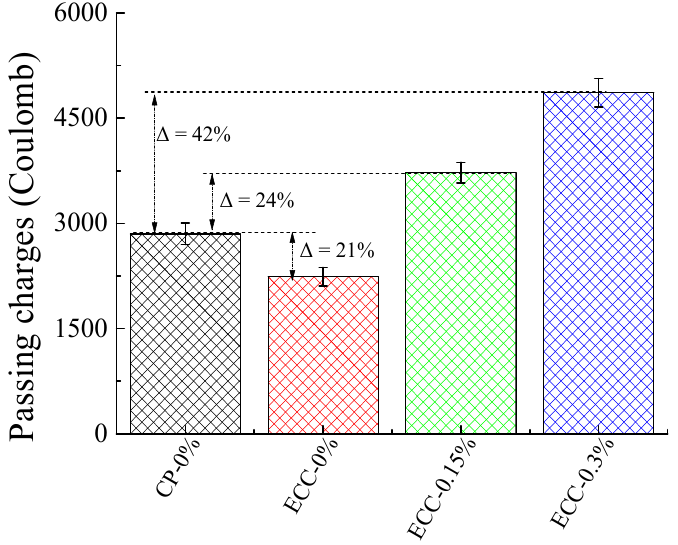
Figure 5. Total charges passed through CP and ECC grouts at 28-days curing. ECC specimens were significantly lower than CP specimens for the total passed charges. Table 3. Chloride permeability based on charge passed (as per ASTM C1202 [23]). Charge Passed (Coulombs)